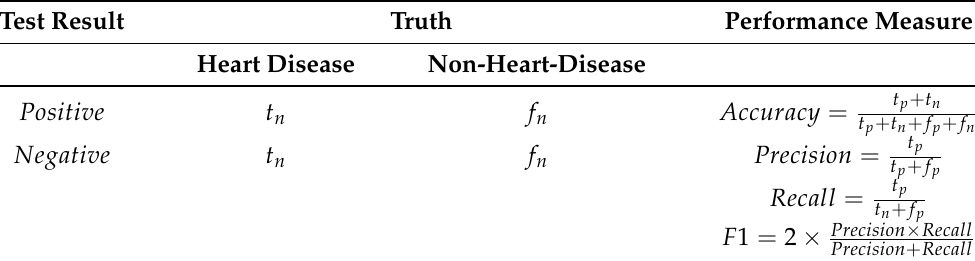
Table 4. The parameter used to compute the confusion matrix